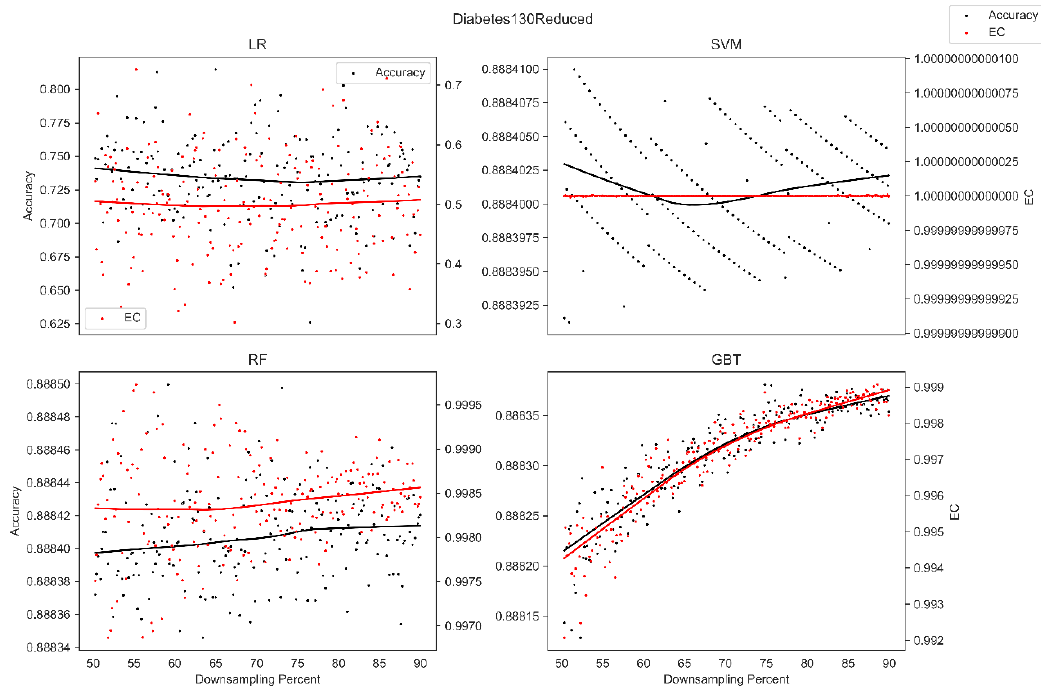
Figure 4. Average error consistency and overall accuracy vs. varying sample size percentages (down-sampled) from the Diabetes 130 dataset. Trend lines were established with locally weighted regression and smoothing [25].